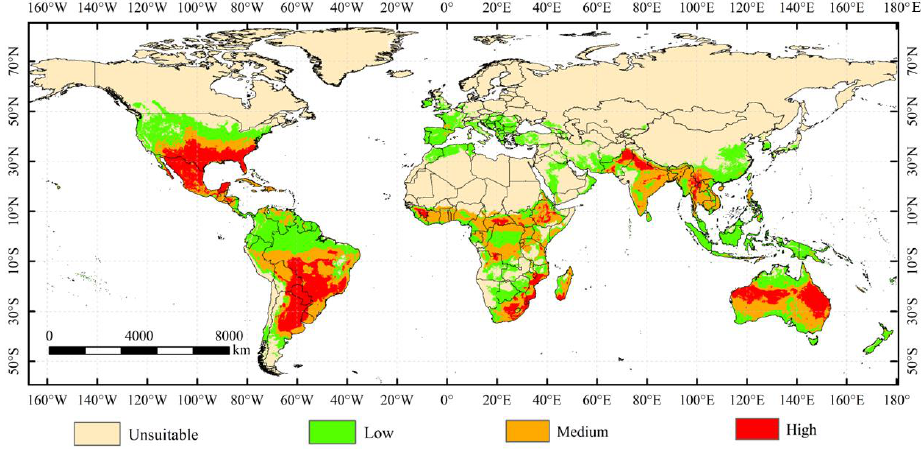
Figure 5. Current global distribution of suitable habitats of Anthonomus grandis .